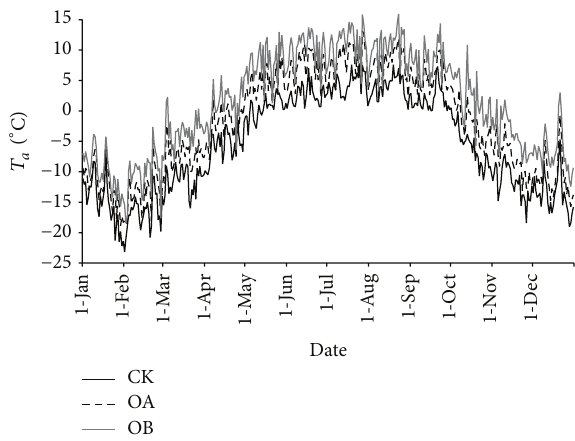
Figure 1: Seasonal variations in the air temperature of the alpine swamp ecosystem corresponding to the warming